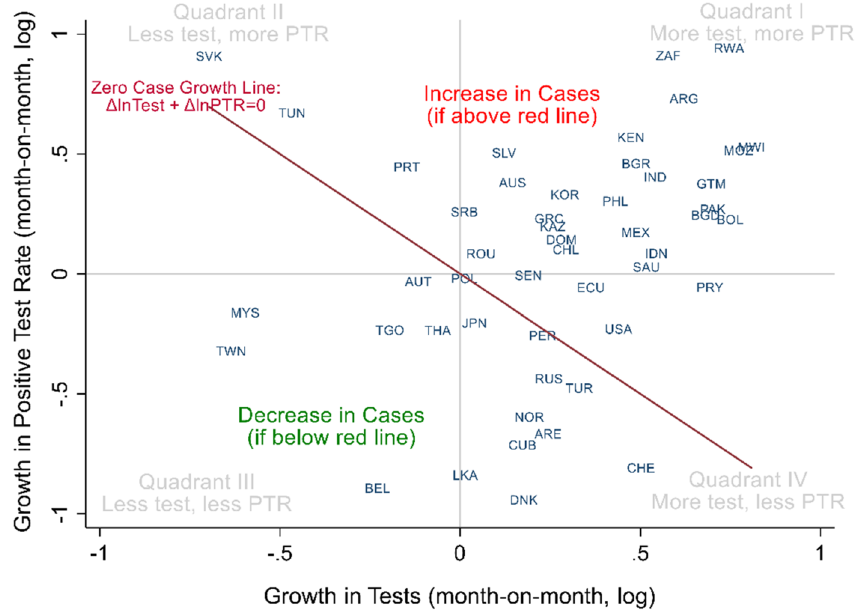
Figure 4. Exact decomposition of Covid-19 cases, month-on-month (growth in June 2020). The line is not a regression but represents the menu of possibilities of zero case growth. Names and abbreviations for countries and US States are included in the Supplementary